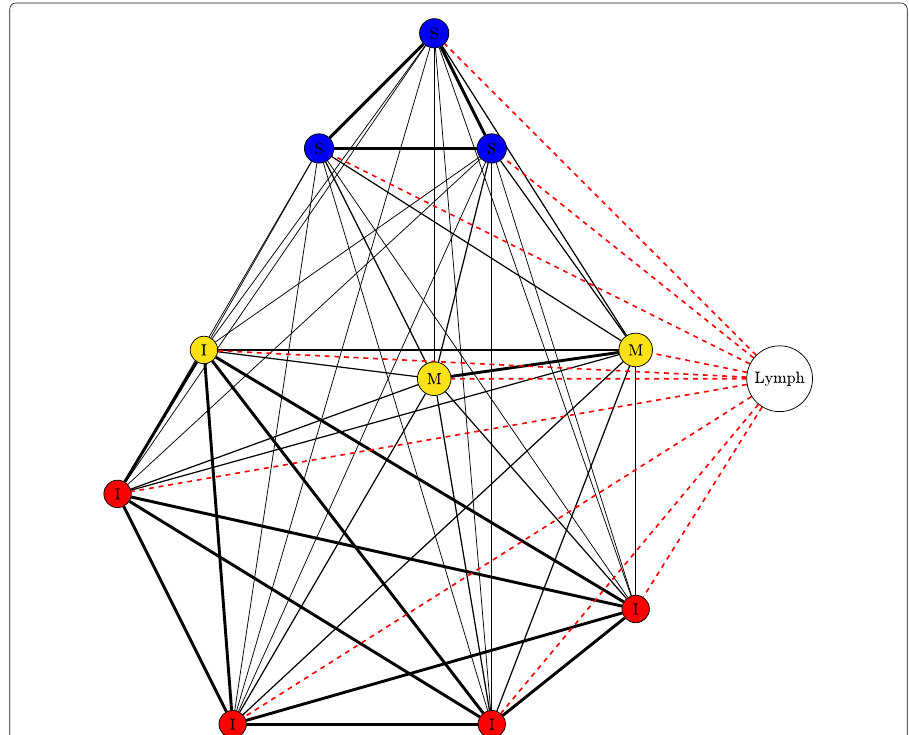
Fig. 4 Structure of topology B. The lung is divided into 10 patches. Patches are assigned into zones based on their vertical position (blue = Zone 1, yellow = Zone 2, red = Zone 3). All patches are connected, and patches within the same lobe (S = Superior lobe, M = Middle lobe, I = Inferior lobe) have greater edge width. All lung patches are connected to/from the LymphPatch by a LymphEdge and a BloodEdge (both edges denoted by a single dotted red